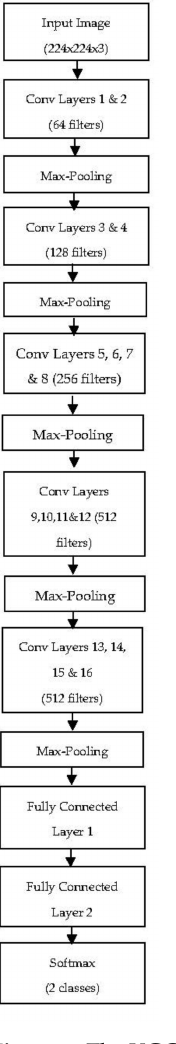
Figure 2. The VGG-19 architecture.